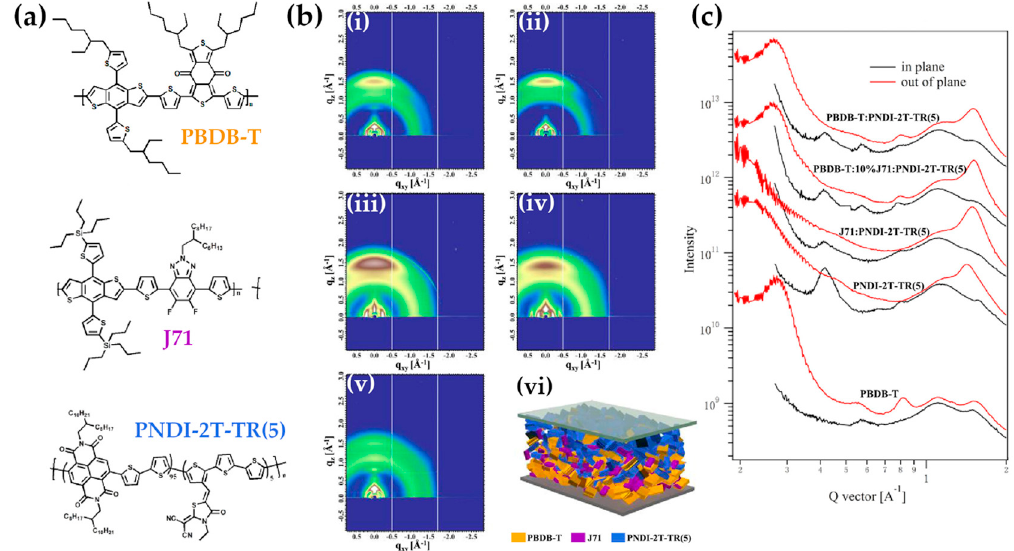
Figure 7. J71 as CB in all-polymer solar cells . ( a ) Chemical structures of PBDB-T (donor), J71 (CB), and PNDI-2TTR (acceptor). ( b ) GIWAXS characterization of (i) PBDB-T:PNDI-2T-TR(5), (ii) PBDB-T:10% J71:PNDI-2T-TR(5), (iii) J71:PNDI-2TTR(5), (iv) PNDI-2T-TR(5), and (v) PBDB-T; (vi) pictorial representation of J71 localization into the PBDB-T:PNDI-2TTR film. ( c ) In-plane and out-of-plane line extracts from the GIWAXS patterns reported in ( b ). Reproduced with permission from Reference [146].